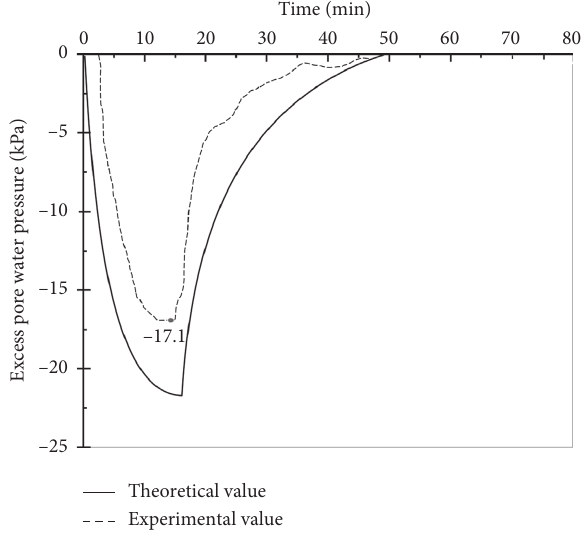
Figure 13: Comparison between theoretical and experimental values of excess pore water pressure.